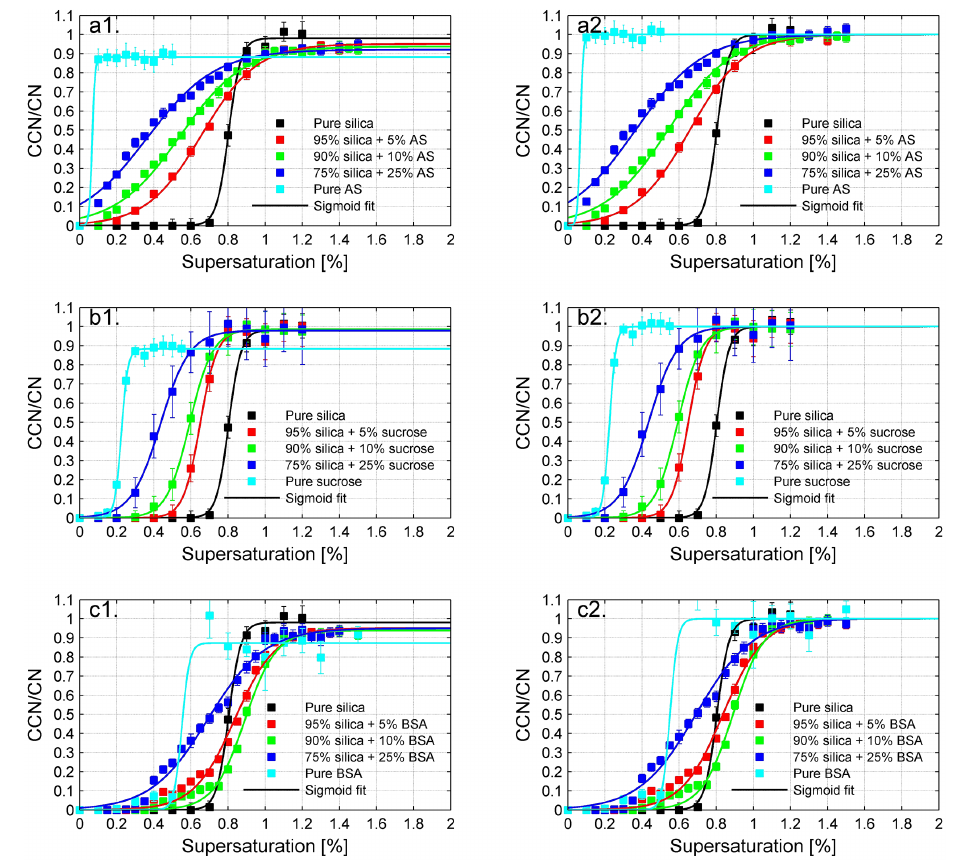
Figure 8. (a) Activation ratio curves for different supersaturations of silica + (NH 4 ) 2 SO 4 particles of 150 nm mobility diameter, (b) ac- tivation ratio curves for different supersaturations of silica + sucrose particles of 150nm mobility diameter, (c) activation ratio curves for different supersaturations of silica + BSA particles of 150nm mobility diameter. The activation curves on the left side (subplots a1–c1) rep- resent the unnormalized data, while the activation curves on the right side (subplots a2–c2) show the normalized ones. Error bars represent the standard deviation of the measured activation efficiency as a result of about 20 measurements corresponding to each supersaturation of the